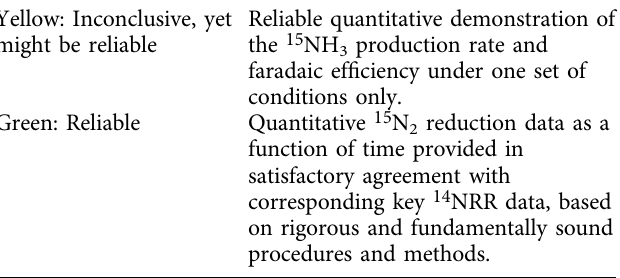
Fig. 1 Electroreductive synthesis of ammonia. Pathways towards NH 3 / NH 4 + through the electrochemical reduction of N 2 , gaseous NO x , and ionic NO x compounds with standard redox potentials (vs. standard hydrogen electrode) and examples 27 – 30,54 – 57 of some of the known electrocatalysts for